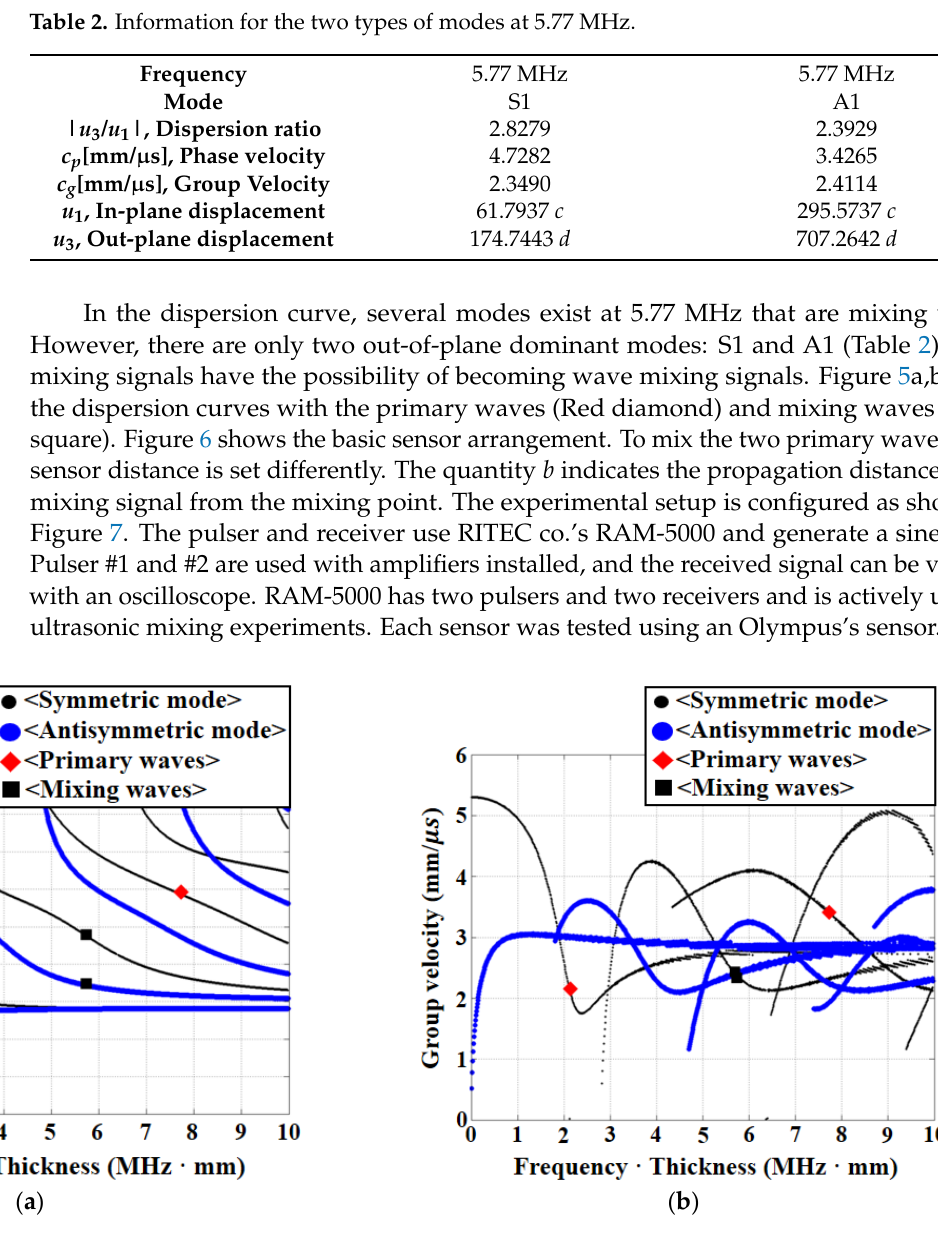
Figure 6. Basic experimental sensor arrangement. Figure 7. Experimental setup for material evaluation by guided wave mixing.